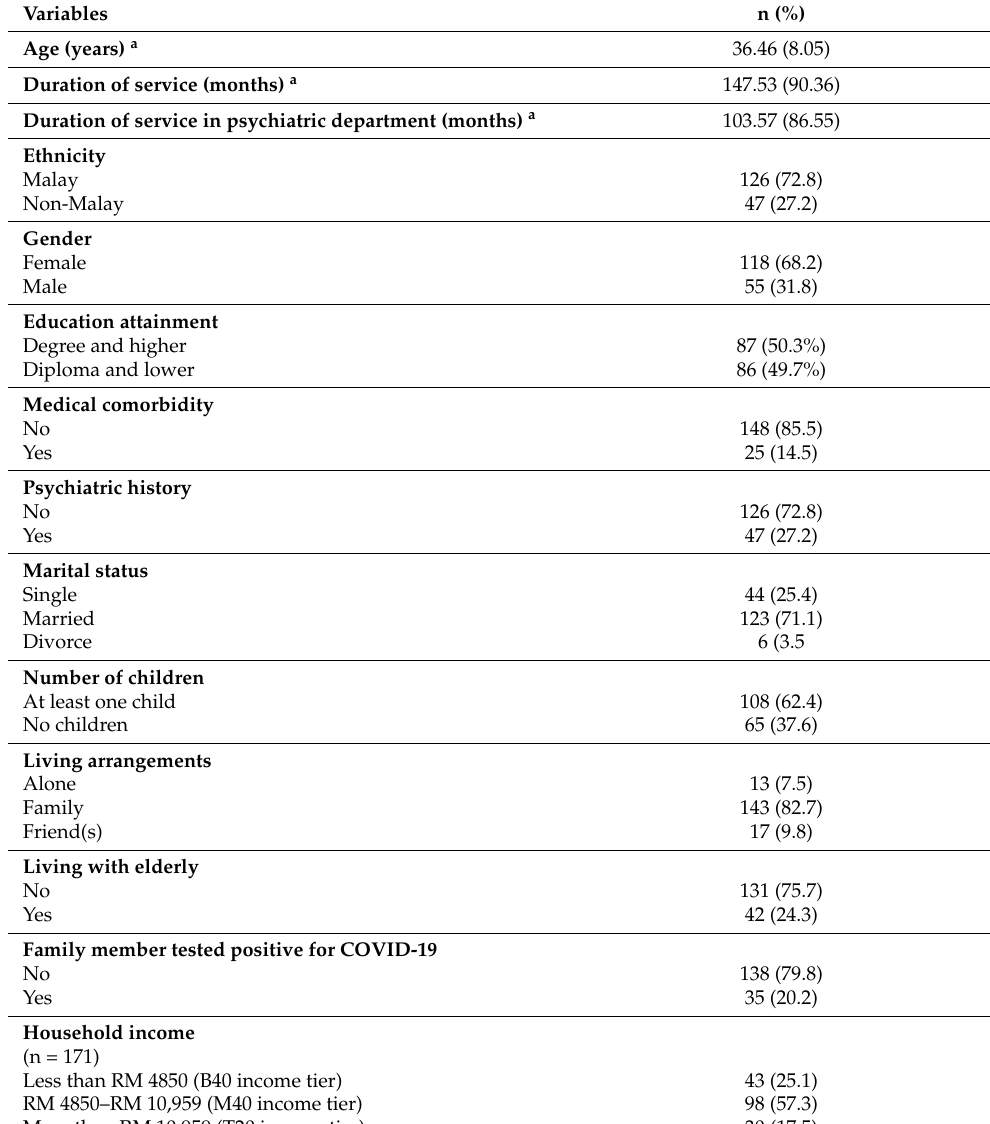
Table 1. Socio-demographic, socio-economic, work-related factors, and coping strategies profiles among psychiatric healthcare workers at University Malaya Medical Centre (n =